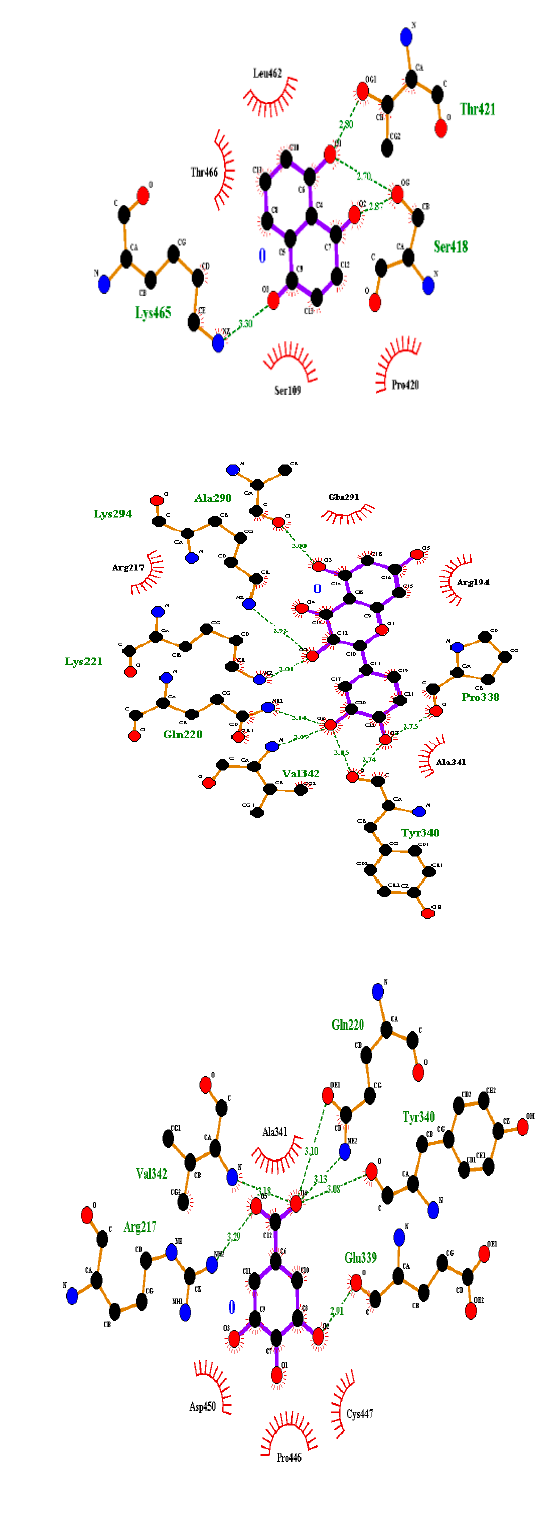
Figure 3. 3D H-bonding interactions of juglone pose no. 5 ( A ), quercetin pose no. 4 ( B ) and gallic acid pose no. 1 ( C ) with binding sites of transcriptional regulator 4F5S (BSA). acid pose no. 1 ( C ) with binding sites of transcriptional regulator 4F5S